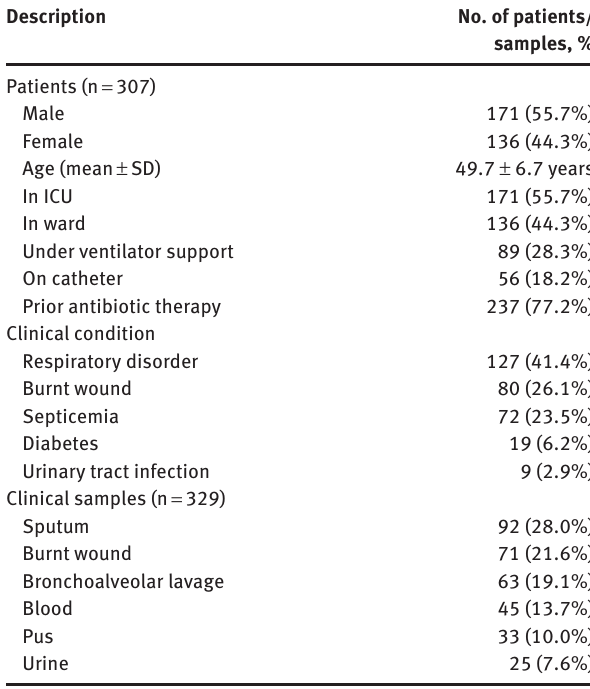
Table 2: Patient demographics and clinical